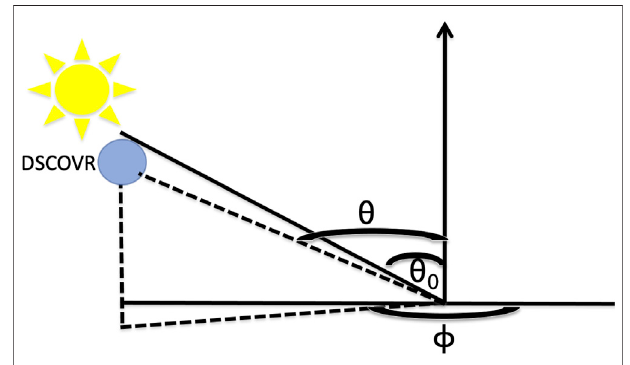
FIGURE 1 | DSCOVR viewing geometry, θ 0 is the solar zenith angle, θ is theDSCOVRviewingzenithangle,and ϕ istherelativeazimuthanglebetween DSCOVR and the solar plane.